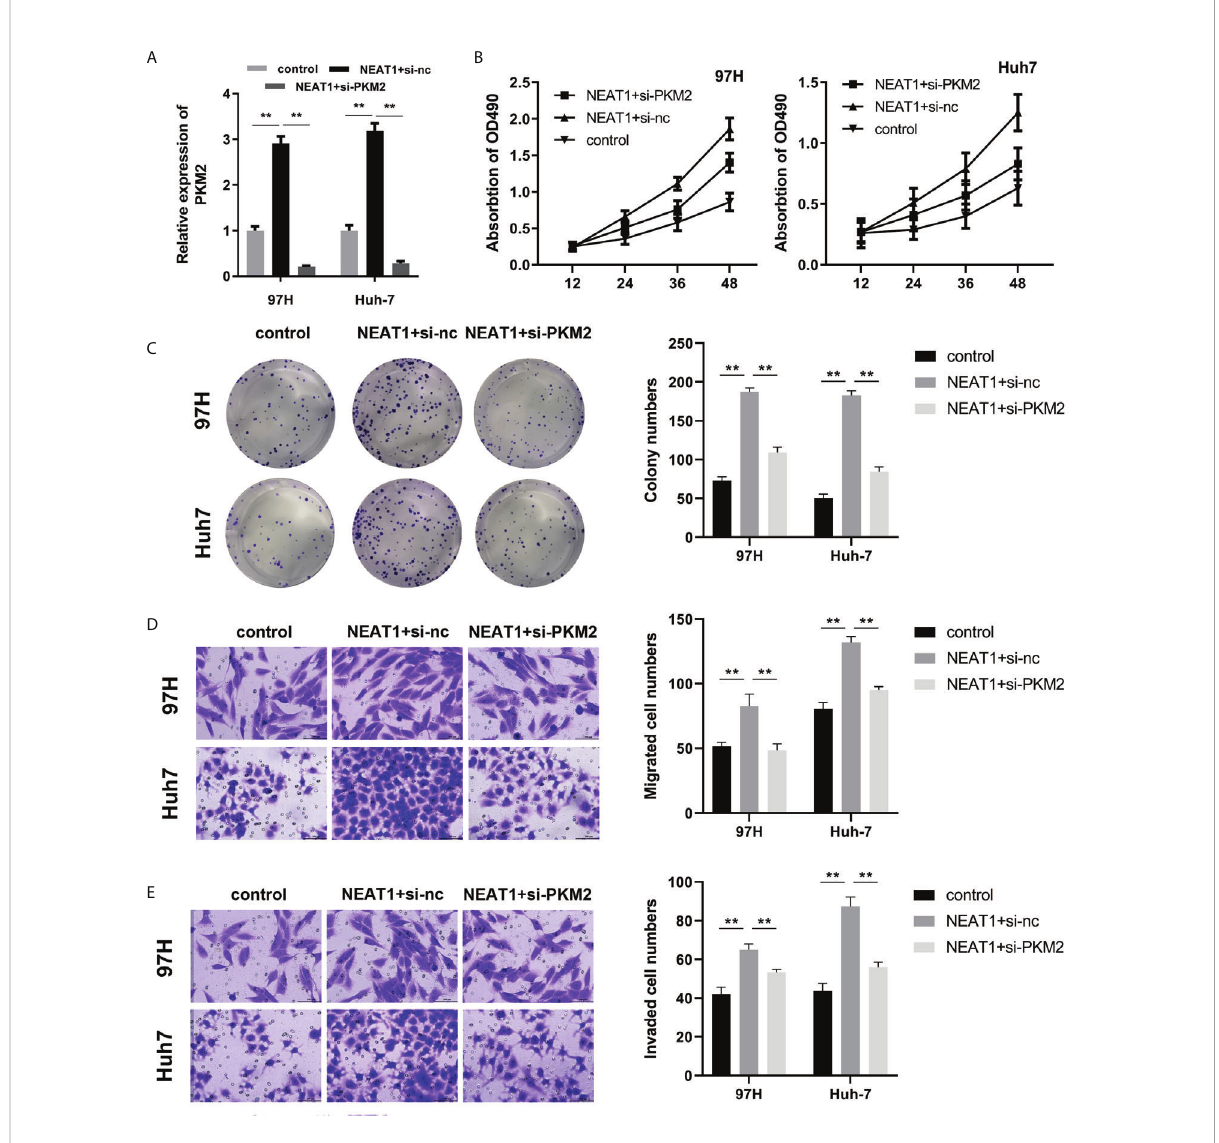
FIGURE 4 PKM2 silencing reversed the function of NEAT1. (A) qPCR was used to detect PKM2 expression. (B) The MTT assay for viability detection was performed. (C) A clone formation assay was used to detect proliferation. (D, E) A Transwell assay was carried out to evaluate cell migration and invasion. ** indicates P <